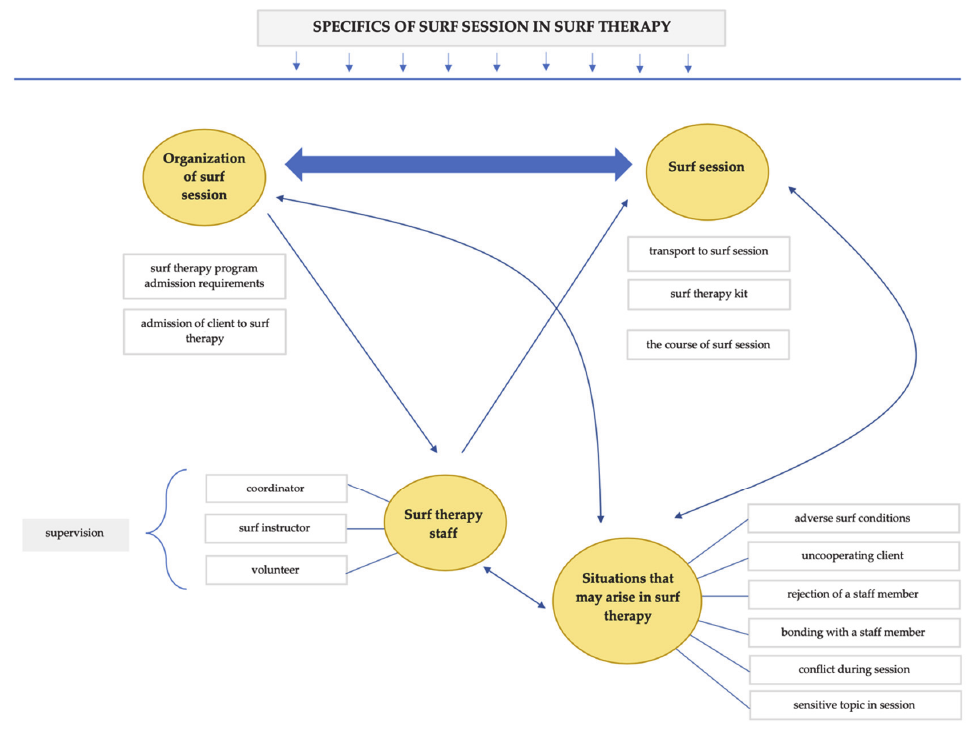
Figure 1. Main clusters and their